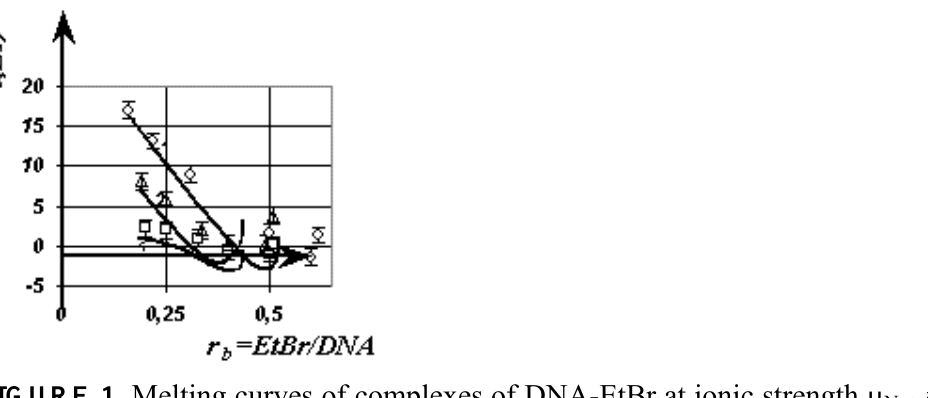
= 2,0 ⋅ 10 -3 М (curve Na +